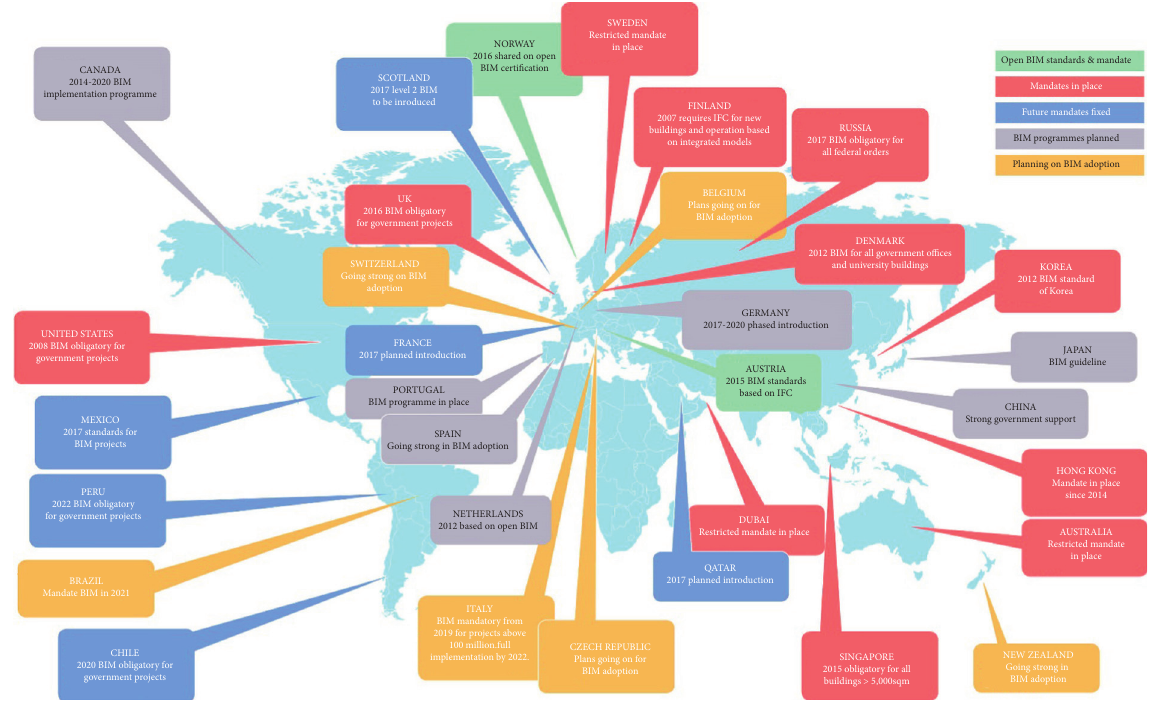
Figure 1: Overview of global BIM adoption